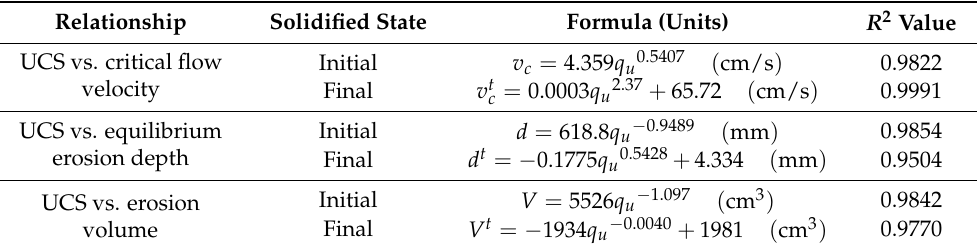
Table 5. Relationship between the UCS and each soil scour resistance performance index. Relationship Solidified State Formula (Units) R 2 Value UCS vs. critical flow Initial v c = 4.359 q u 0.5407 ( cm/s ) 0.9822 velocity Final v t c = 0.0003 q u 2.37 + 65.72 ( cm/s ) 0.9991 UCS vs. equilibrium Initial erosion depth UCS vs. erosion volume